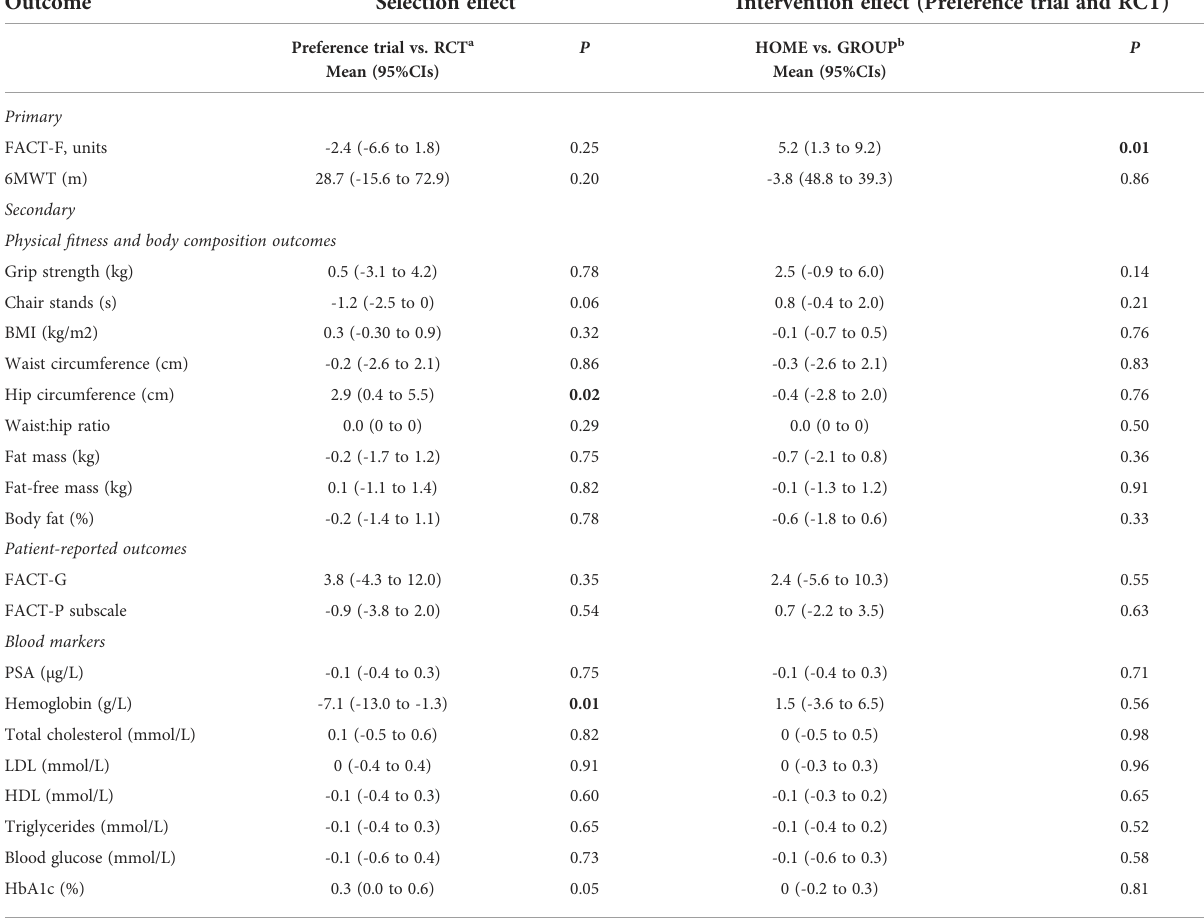
TABLE 6 Overall selection and intervention effects between trials and study arms for outcomes without potential differential